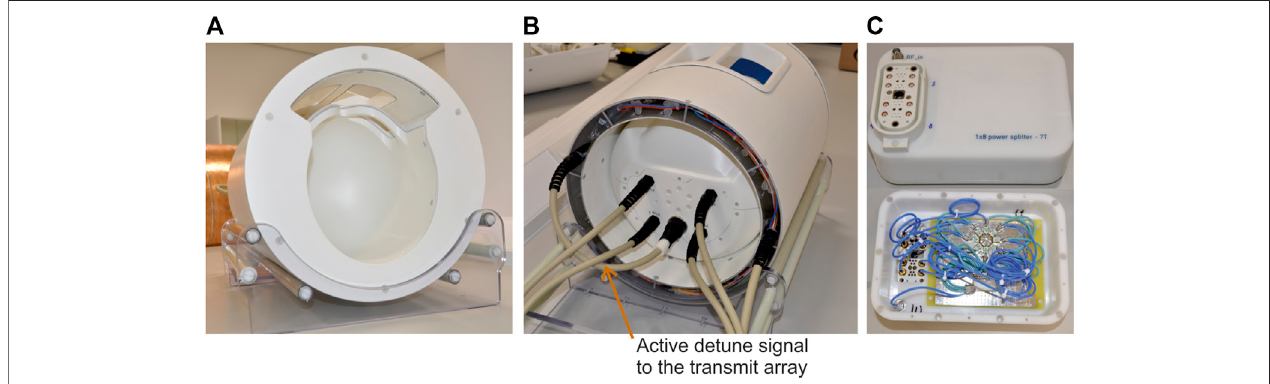
FIGURE3|(A) Thecompletedcoilassembly. (B) Viewofthecoilfromtheservice-end. (C)